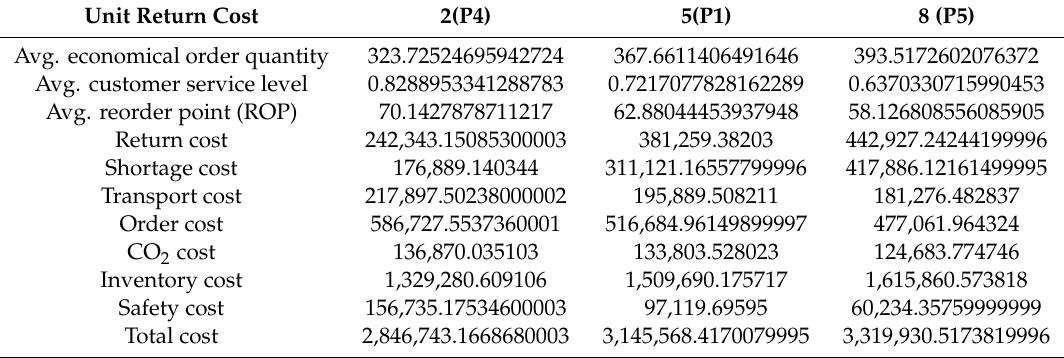
Table 15. The results of the sensitivity analysis for unit return cost based on ROPIRPSDRCO 2